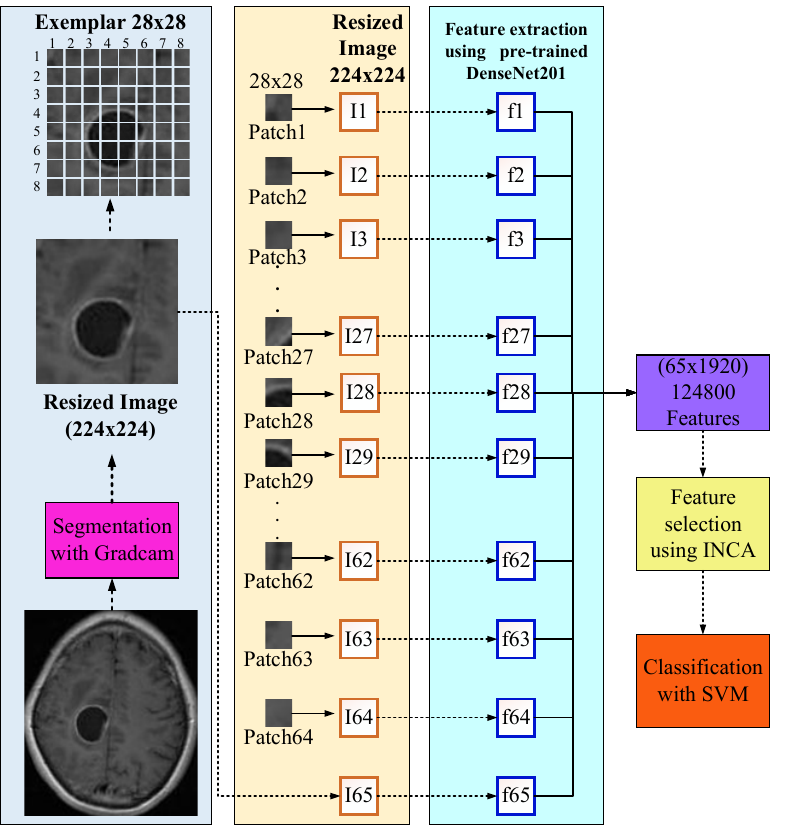
Figure 2. Graphical representation of the presented XAI model. The general steps of the proposed model are given below.